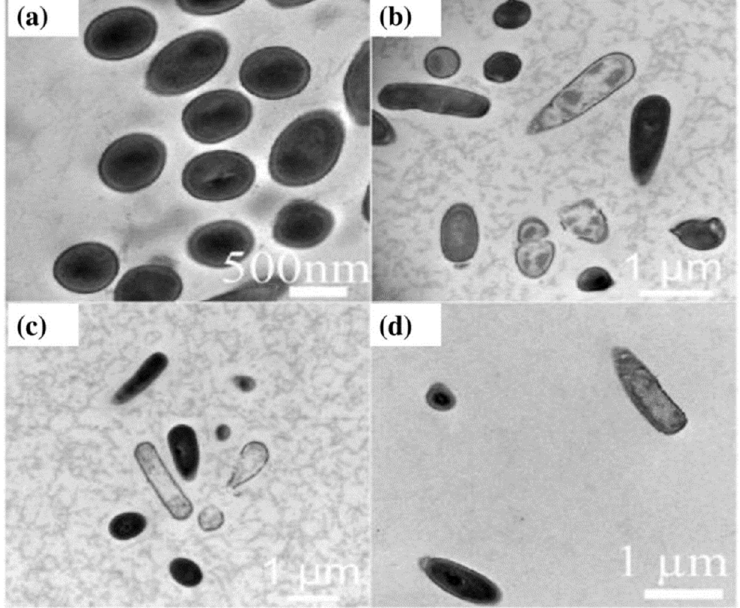
Figure 14. TEM images of B . atrophaeus ( a ) control, ( b ) ZnO powders, ( c ) ZnO nanorods, and ( d ) ZnO nanoparticles. Reprinted/adapted with permission from Ref. [172]. Copyright © 2022, Elsevier B.V.